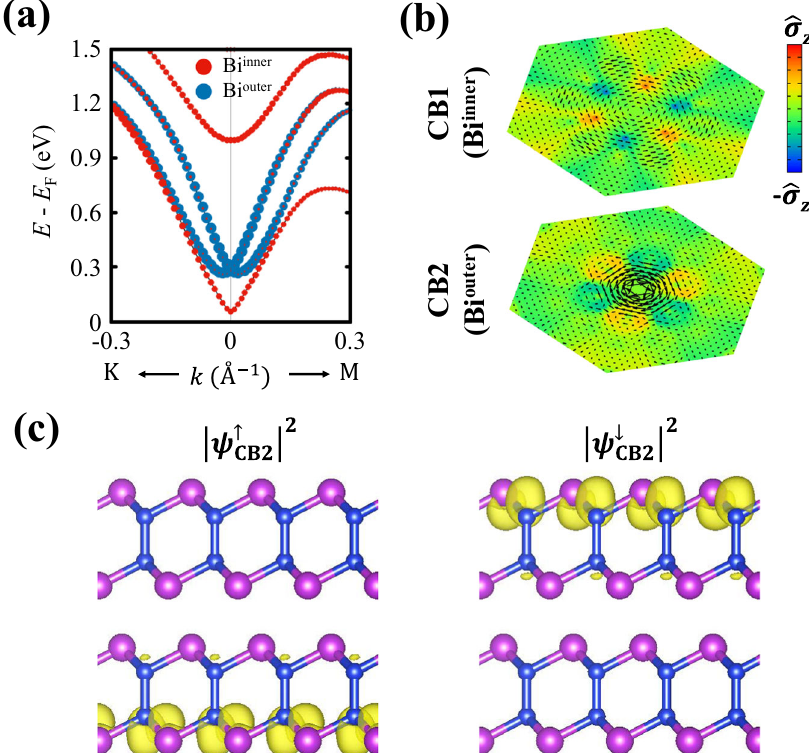
Fig. 4 Effect of the interlayer interaction on hidden Rashba states. a Four lowest conduction bands (CB1 through CB4 in ascending order in energy) of a I -Si 2 Bi 2 bilayer spatially resolved on the inner Bi SLs, Bi inner (red circles) and on the outer ones, Bi outer (blue circles). The size of circles indicates the amount of their contributions, which are well separated especially near the Γ point. b Spin textures computed from CB1 and CB2 localized on Bi inner and Bi outer , respectively. The size of black arrows and different colors indicate, respectively, the in-plane and out-of- j 2 , with σ = ↑ and ↓ for the CB2 band evaluated at k = plane spin components. c Spatially projected spinor wavefunction squared, j ψ σ CB2 0.03 π a − 1 along the Γ − M line close to the Γ